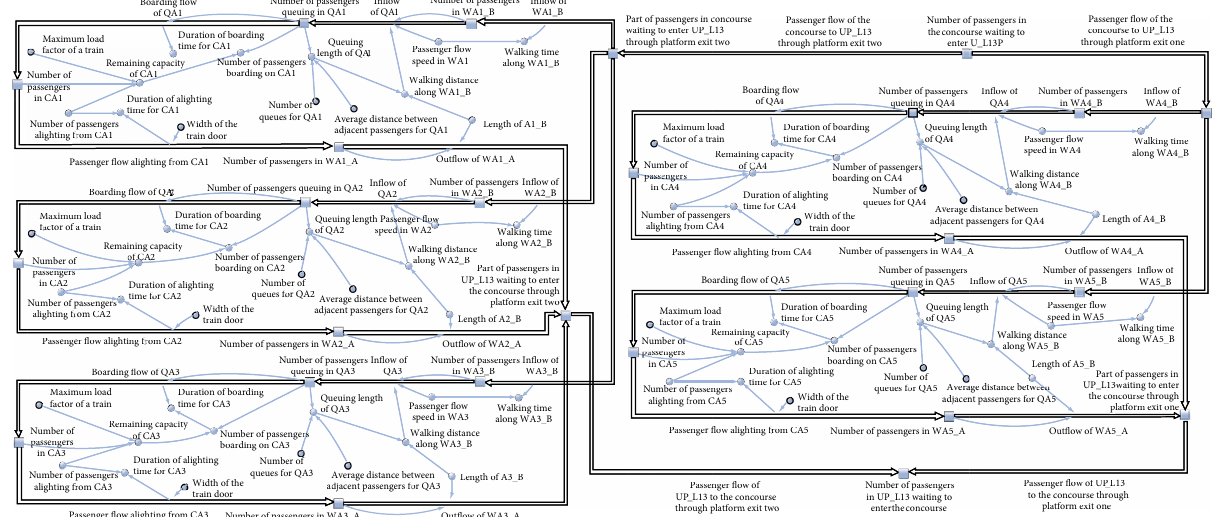
Figure 12: Stock and flow diagram for waiting-boarding trains at UP_L13. To differ from the alighting process where WA is marked as WA_B, and there is no QA in this process. WA for the process of waiting-boarding trains is marked as WA_A.